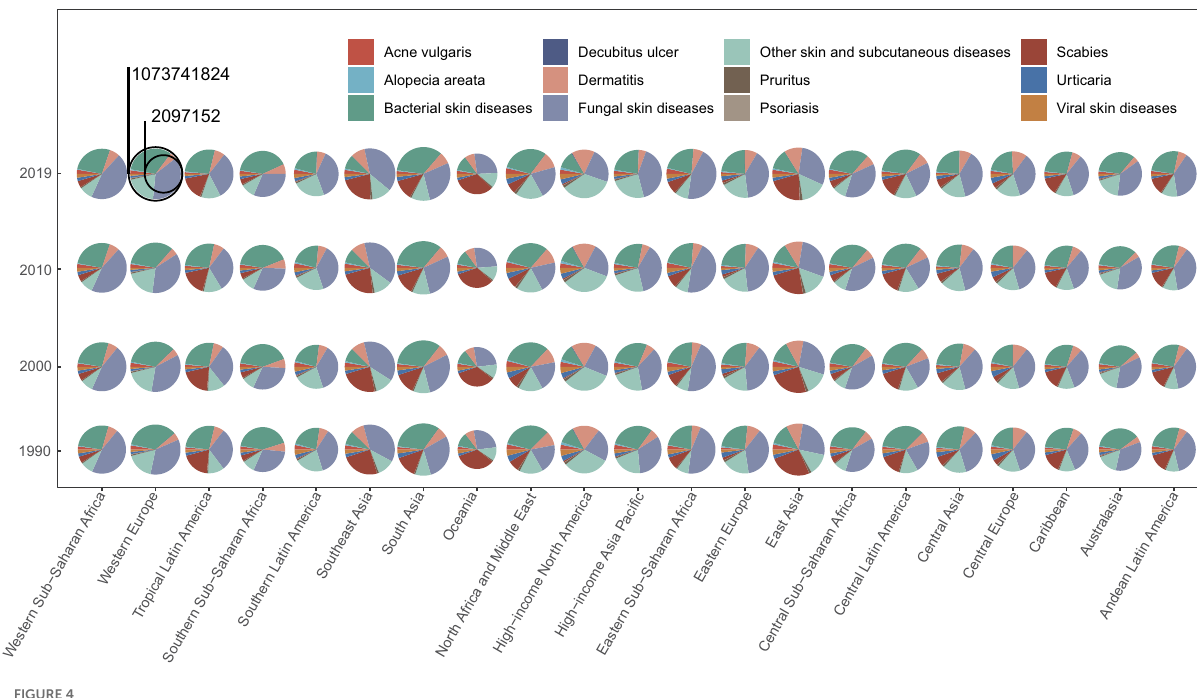
FIGURE4 Skin and subcutaneous diseases burden in different regions. The proportion of new cases of each skin and subcutaneous disease at different GBD regions (21) in 1990, 2000, 2010, and 2019. GBD, Global Burden of Disease.